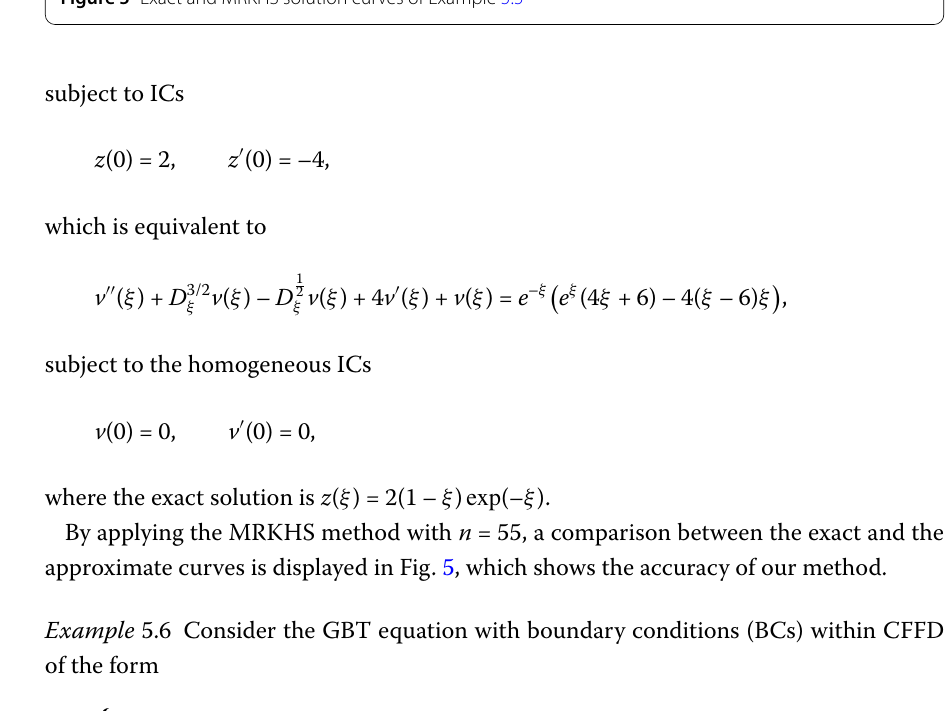
Figure 5 Exact and MRKHS solution curves of Example